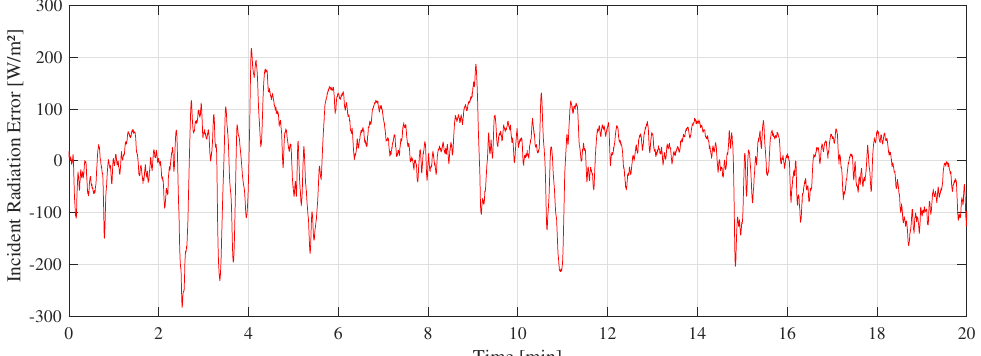
Figure 15. Difference between SR-05 and CTD prototype in B measurement.